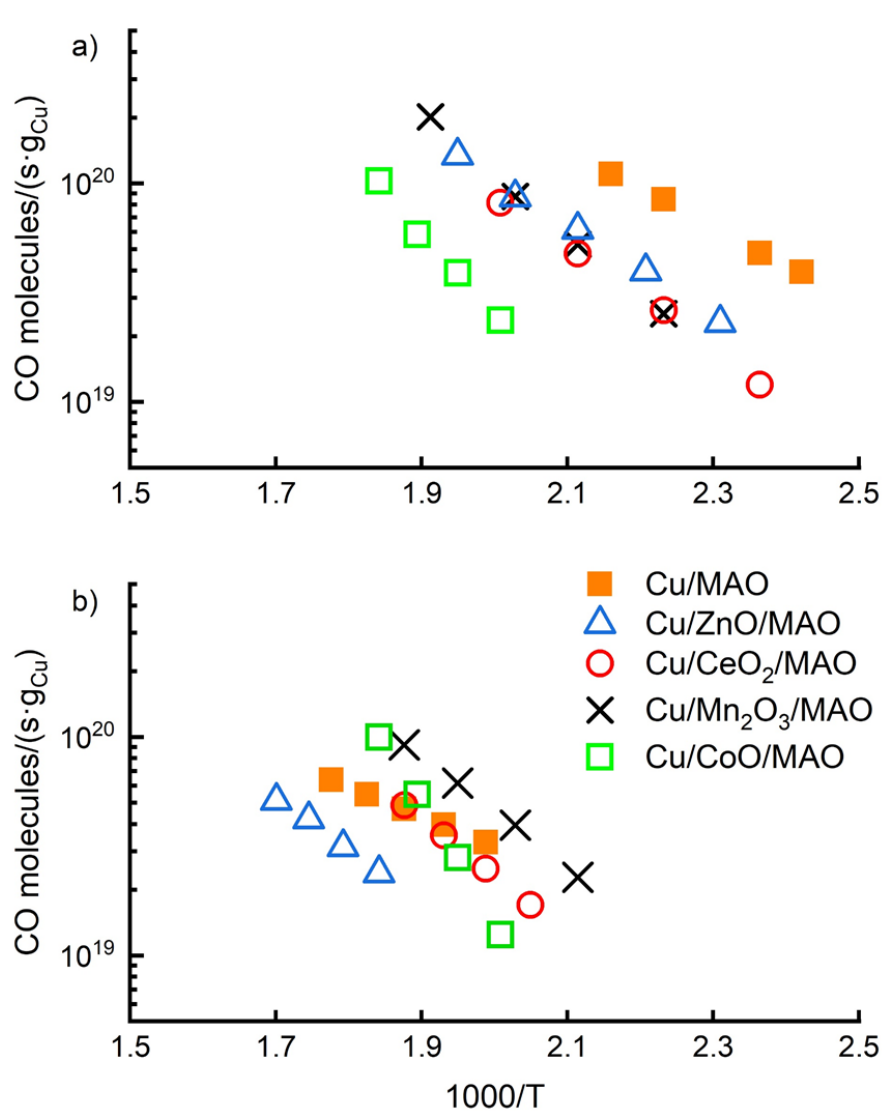
Figure 6. Differential WGS rates on catalysts reduced at ( a ) 623 K and ( b ) 1073 K.